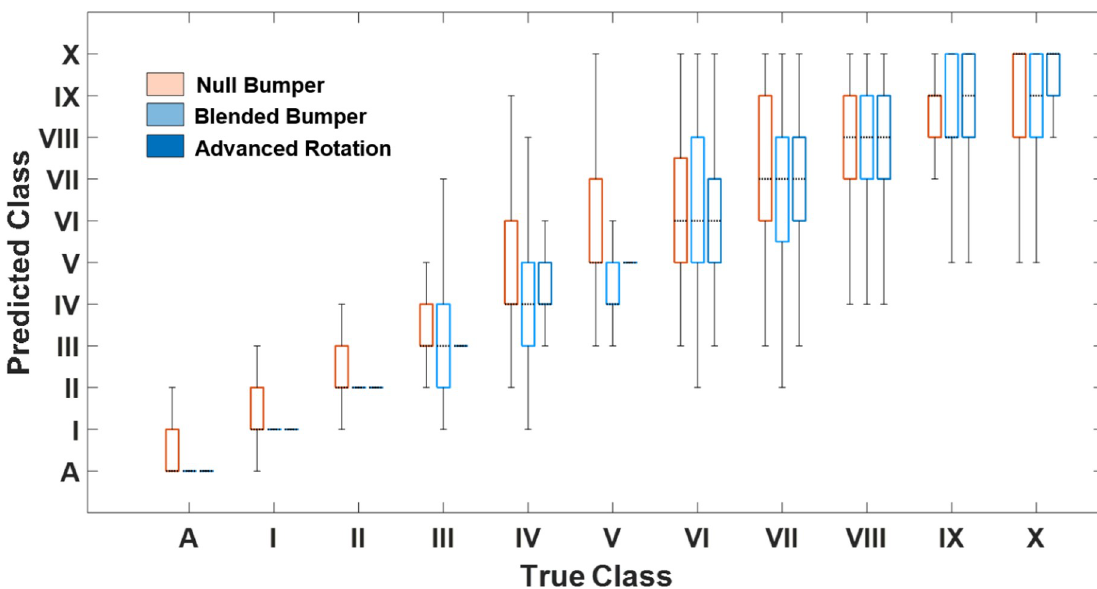
Fig 3. Accuracy of NB, BB and AR trained cCNNs across all output classes (A, I-X cell clusters). Standard box and whisker levels are used with the center mark (dotted line) indicating the median, the bottom and top edges of the box indicating the 25th and 75th percentiles, respectively, the whiskers extending to the most extreme data points not considered